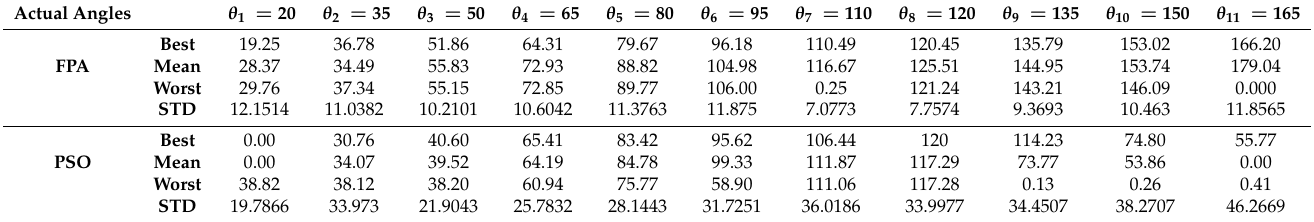
Table 9. Estimation accuracy and STD for eleven targets at SNR = − 10 dB.